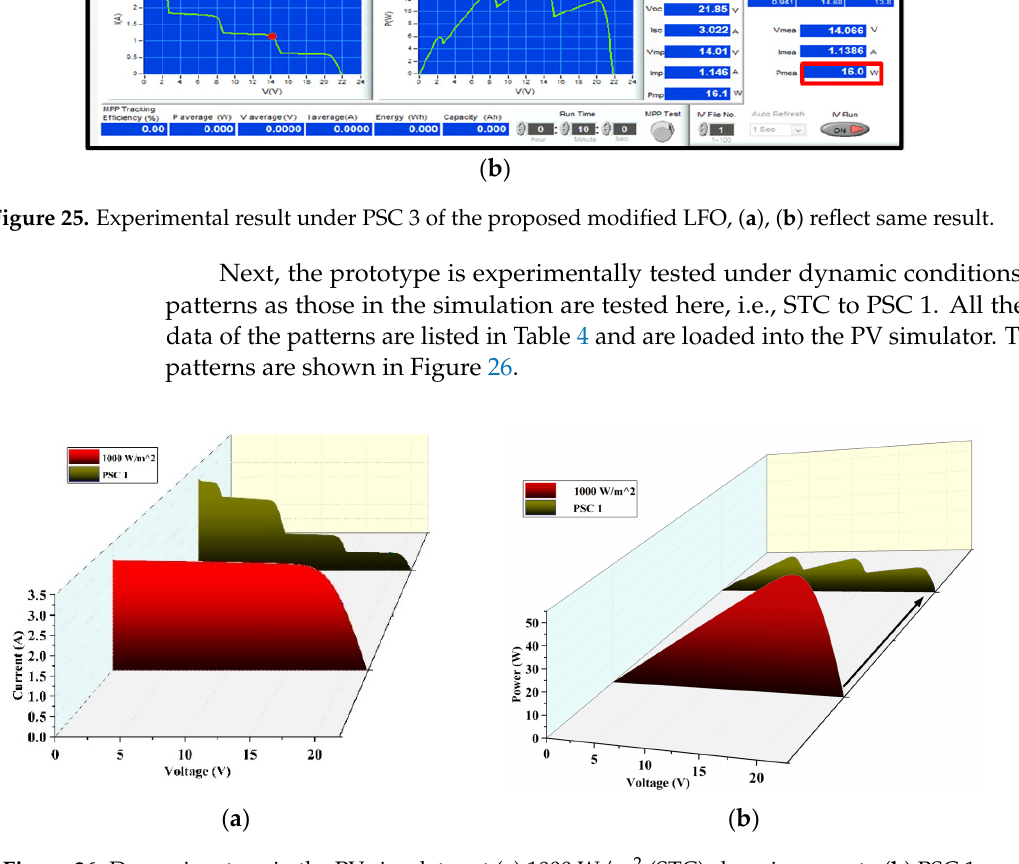
Figure 26. Dynamic set-up in the PV simulator at ( a ) 1000 W/m 2 (STC) changing over to ( b ) PSC 1.